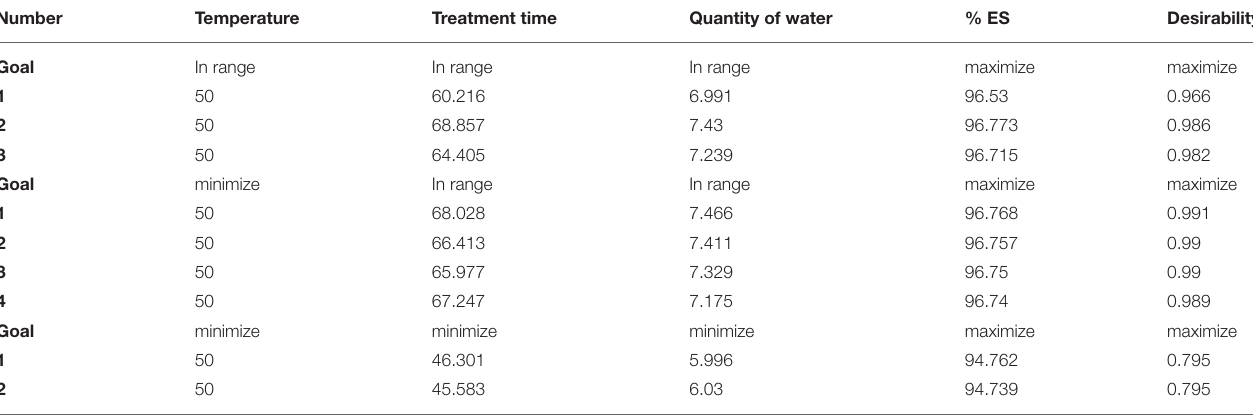
TABLE 3 | Numerical optimization of quadratic model.